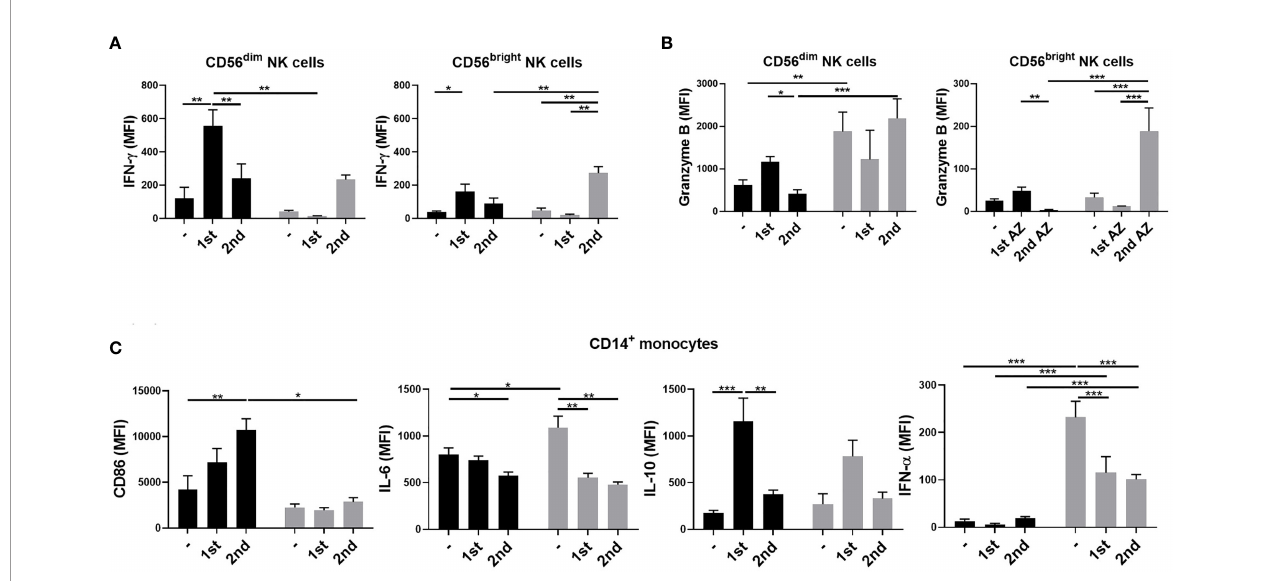
FIGURE 3 | NK cell and monocyte activation 3 days after ChAdOx1 nCoV-19 vaccination. PBMCs were isolated from young (black bars) and older adult vaccinees (gray bars) 3 days after the fi rst and second vaccinations. IFN- g (A) and granzyme B (B) expression in CD3 - CD56 dim or CD3 - CD56 bright NK cells; CD86, IL-6, IL-10, and IFN- a in monocytes (C) of the young and older adult vaccinees were analyzed by fl ow cytometry. Statistical signi fi cance was determined using ANOVA with Tukey ’ s multiple-comparisons testing between all groups. (Black: young vaccinees; Grey: older adult vaccinees). (* p value < 0.05; ** p value <0.01; *** p value < 0.001).